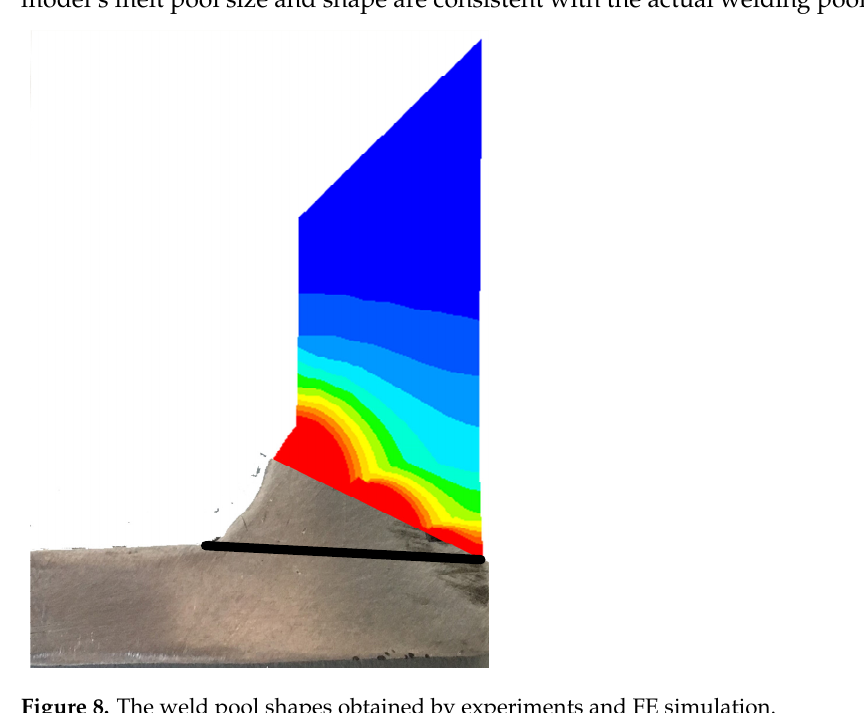
Figure 8. The weld pool shapes obtained by experiments and FE